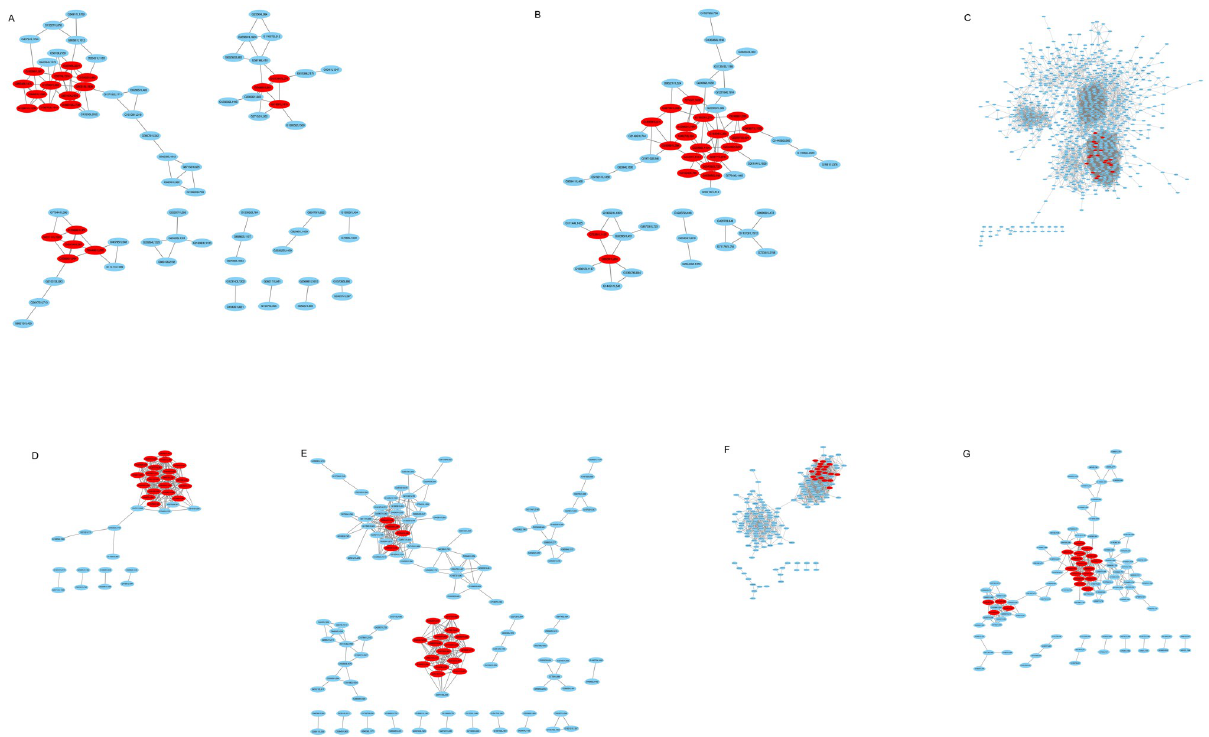
Fig 11. A total number of 140 hub genes in seven modules. The top 20 hub genes in each selected module, including blue2 (A), chocolate3 (B), coral3 (C), coral4 (D), darkorange2 (E), lightpink4 (F), and lightsteelblue (G) modules. Nodes represent genes in the network and red nodes indicate the hub genes. The gray line connecting two nodes indicates their